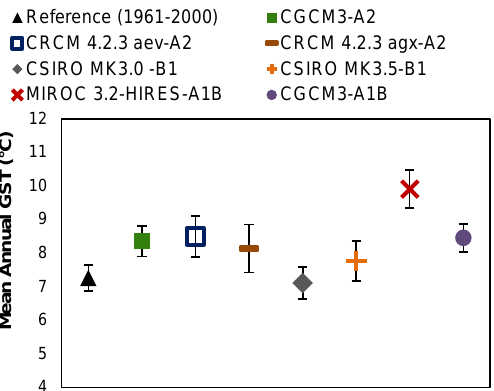
Fig. 6. ForHyM2-simulated mean annual GST for each climate sce- nario (2046–2065). Simulated mean annual GST based on the his- torical climate data (1961–2000) is indicated by the data point to the far left. Error bars indicate one standard deviation in mean annual GST.